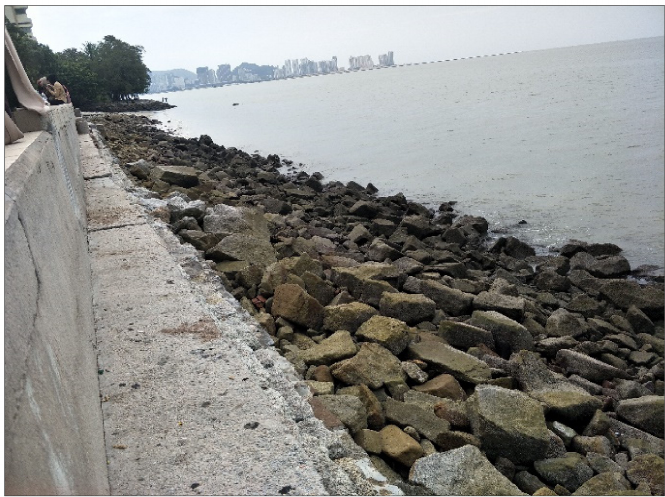
Figure 3. Non-accessible and less aesthetical tourist beaches due to hard structures.